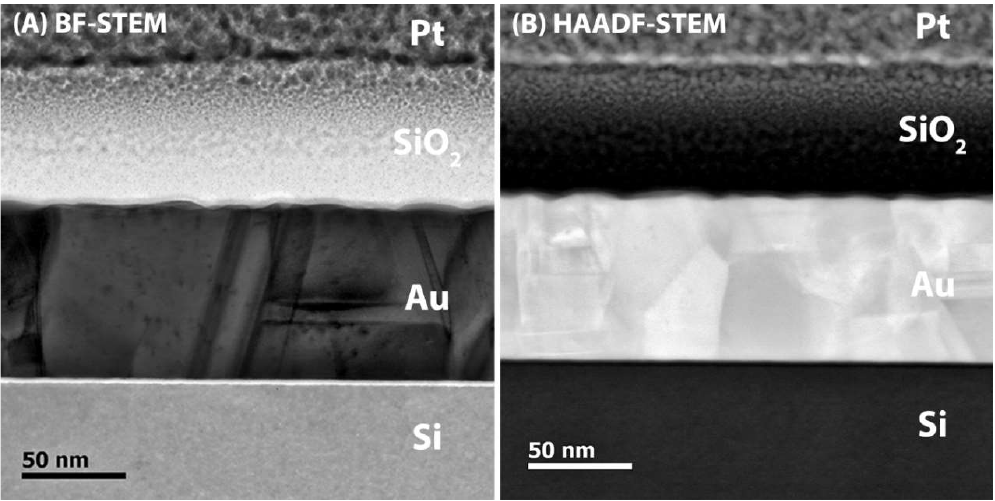
Figure 6. Cross-sectional ( A ) BF- and ( B ) HAADF-STEM image of TiO 2 /Au/silicon model sample a. Individual layers can be distinguished by using Z-contrast.